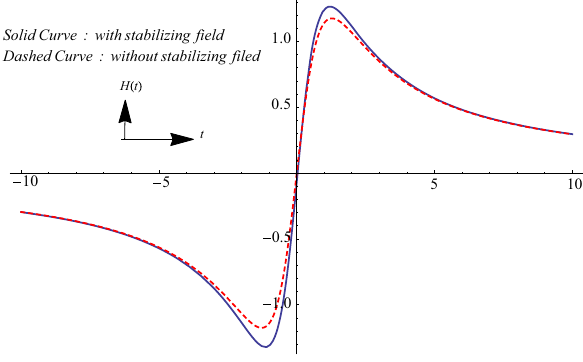
Fig. 3 H ( t ) vs. t , with/without the stabilizing field for B = 1, D = = 1 . 5 and m = 0 . 2 0 . 5, v h v k v